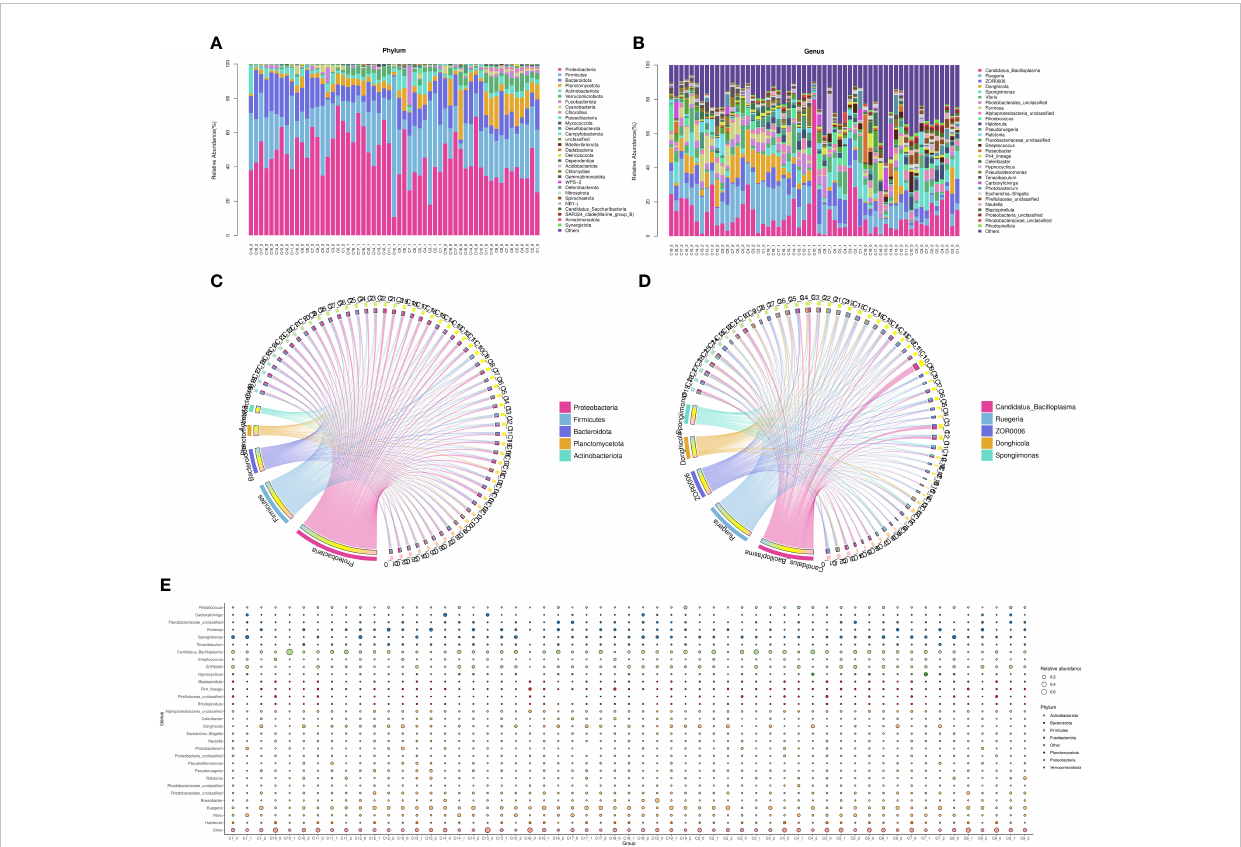
FIGURE 5 The microbial community composition in the intestine. (A) The distribution of the top 30 relative abundant species in each group at phylum level, (B) The distribution of the top 30 relative abundant species in each group at genus level, (C) The circus of top 5 relative abundant species in each group at phylum level, (D) The circus of top 5 relative abundant species in each group at genus level, (E) Species annotation information and relative abundance (circle size) at genus level in different sample